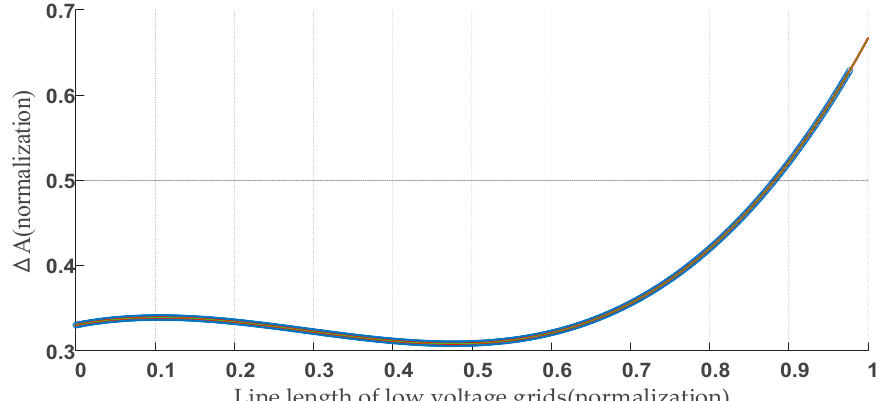
Figure 2. Correlation between line length and Δ A .